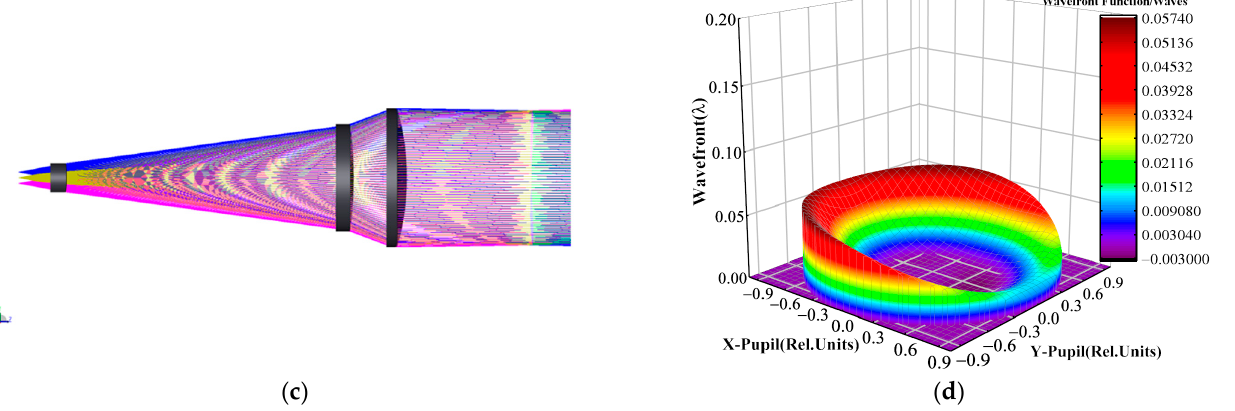
Figure 7. MS design results: ( a ) the layout of the lens unit; ( b ) the full field spot diagram of the lens unit; ( c ) the layout of the collimator lens; ( d ) wavefront diagram of the light beam of the collimator lens at edge FOV.